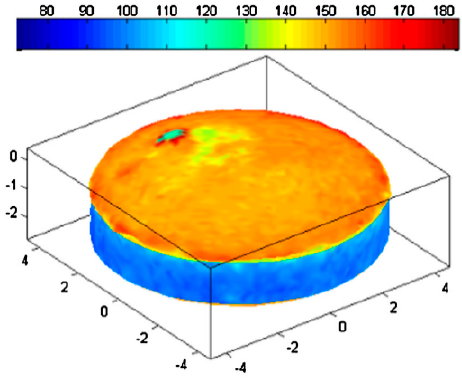
Figure 14. 3D images of coating thickness of a biconvex tablet. The colour scale is in µ m, the X-Y-Z scale is in mm. Reprinted with permission from [89] © Elsevier.